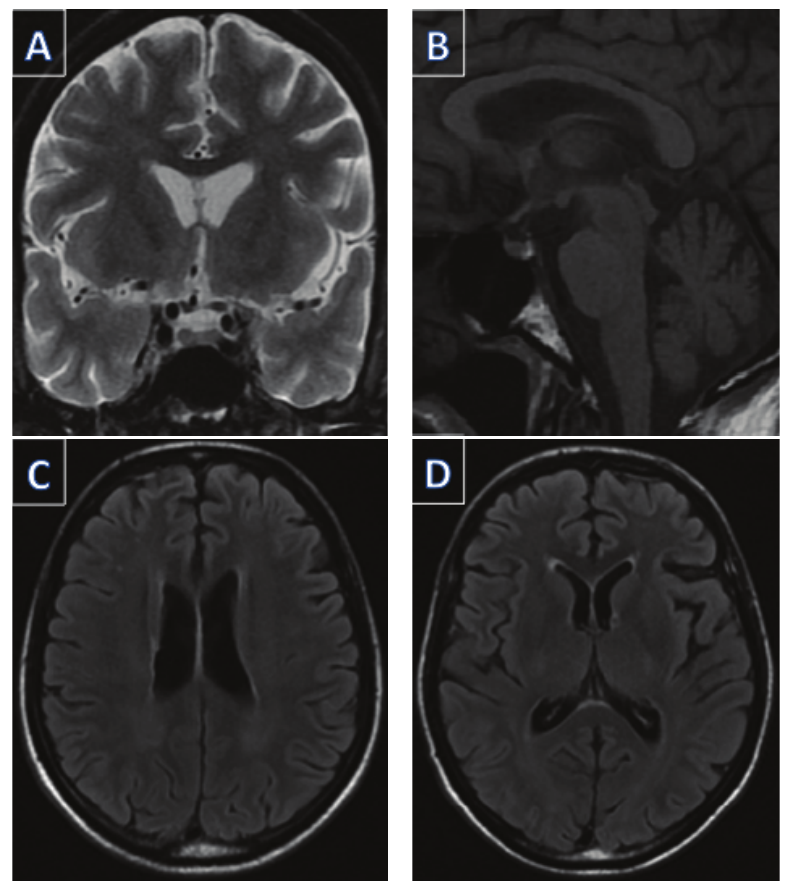
Figure 1: Magnetic resonance imaging of the brain was performed without significant